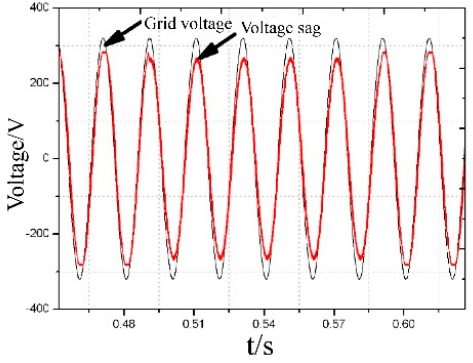
Figure 24. Voltage sag experiment after grid connection.